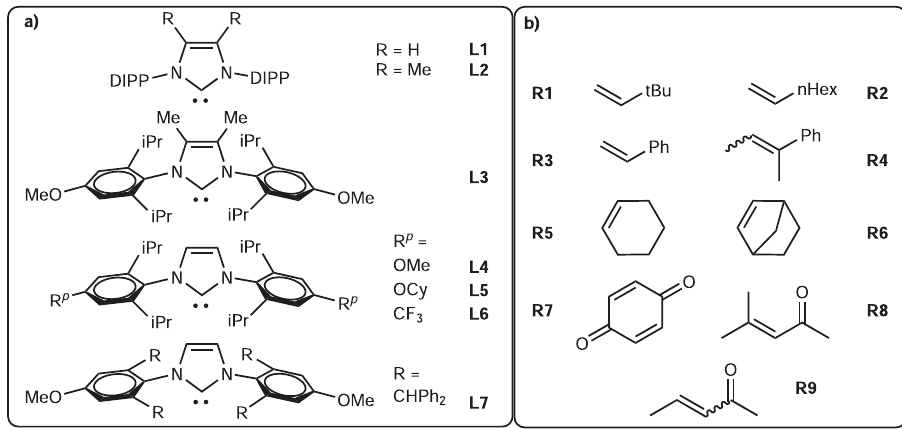
Fig. 2 | N-Heterocyclic carbene L and regulator R employed in this study. a NHC L1-7 structures . b Regulator R1-9 structures.